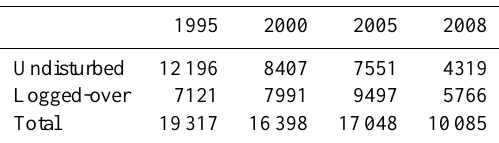
Table 1. Forest cover (km 2 ) in time in the Berau district after Ekad- inata et al.